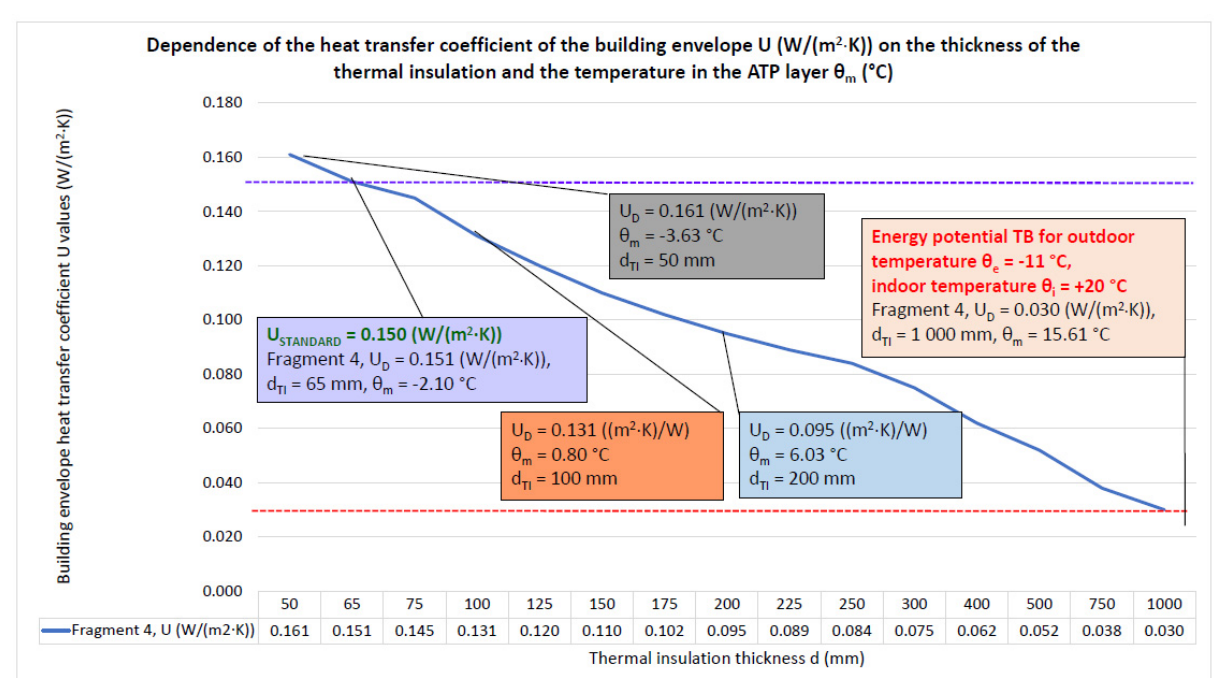
Figure 33. Dependence of the dynamic heat coefficient U D (W/(m 2 · K)) on the thickness of the thermal insulation and the mean temperature θ m (°C) in the ATP layer—Fragment 4.